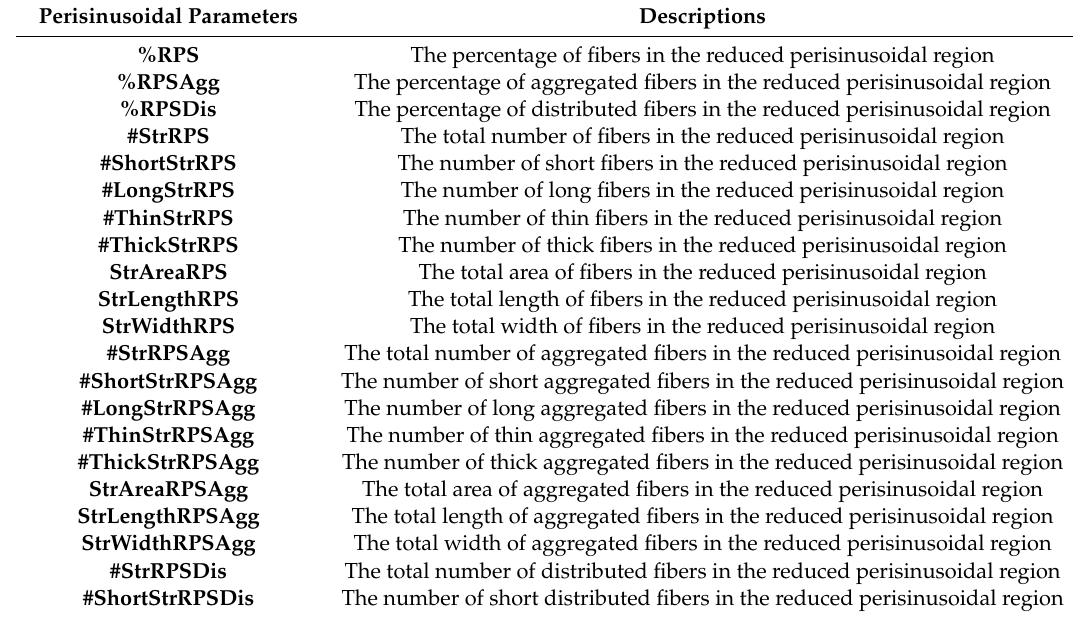
Table 3. List of altered perisinusoidal